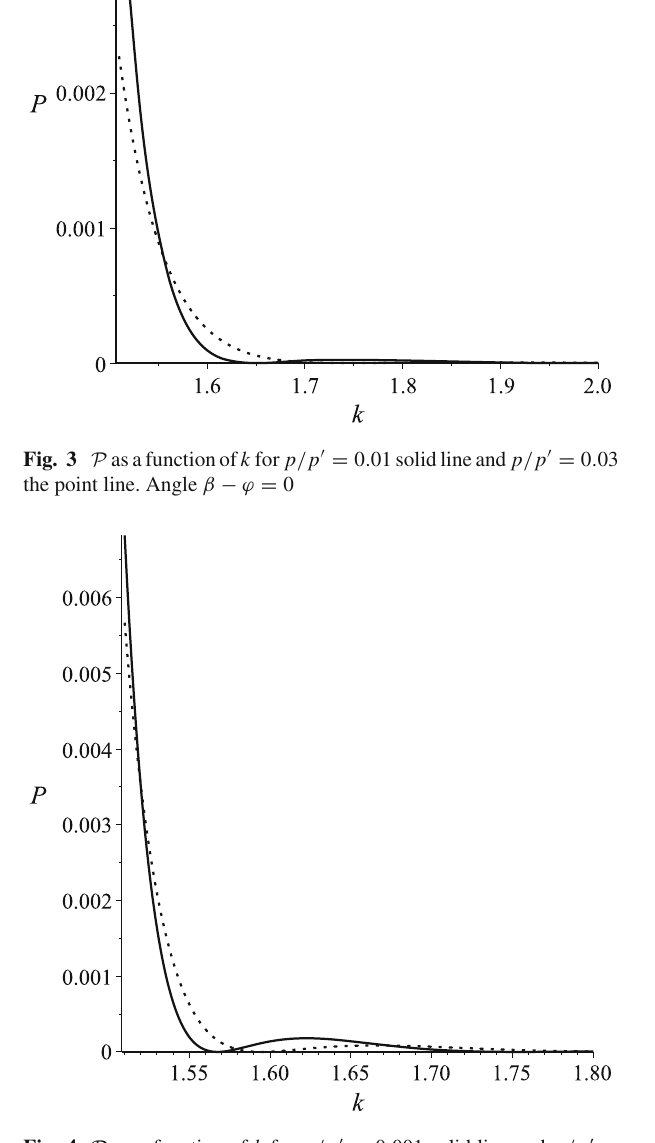
Fig. 2 P as a function of k for p / p (cid:8) = 0 . 9 solid line and p / p (cid:8) = 0 . 8 the point line. Angle β − ϕ = π